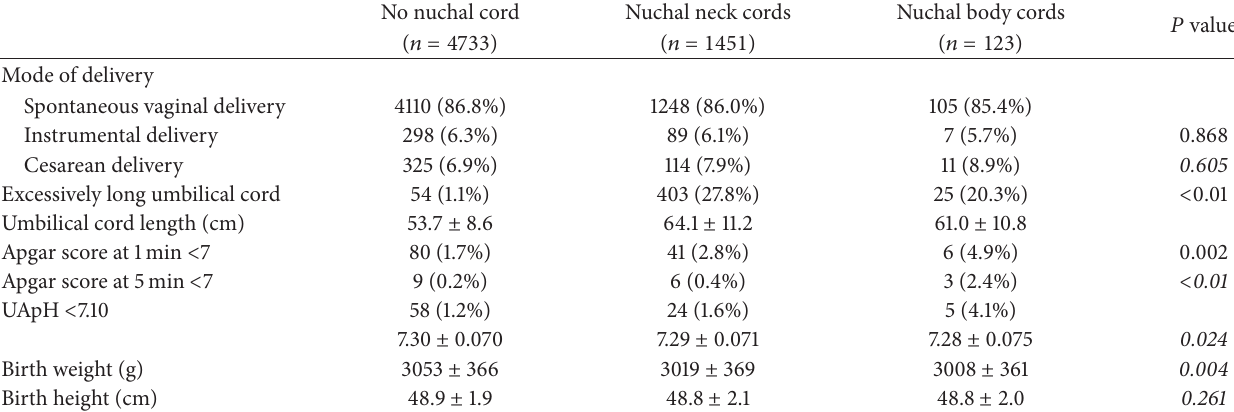
Table 2: Comparison of pregnancy outcomes between the 3